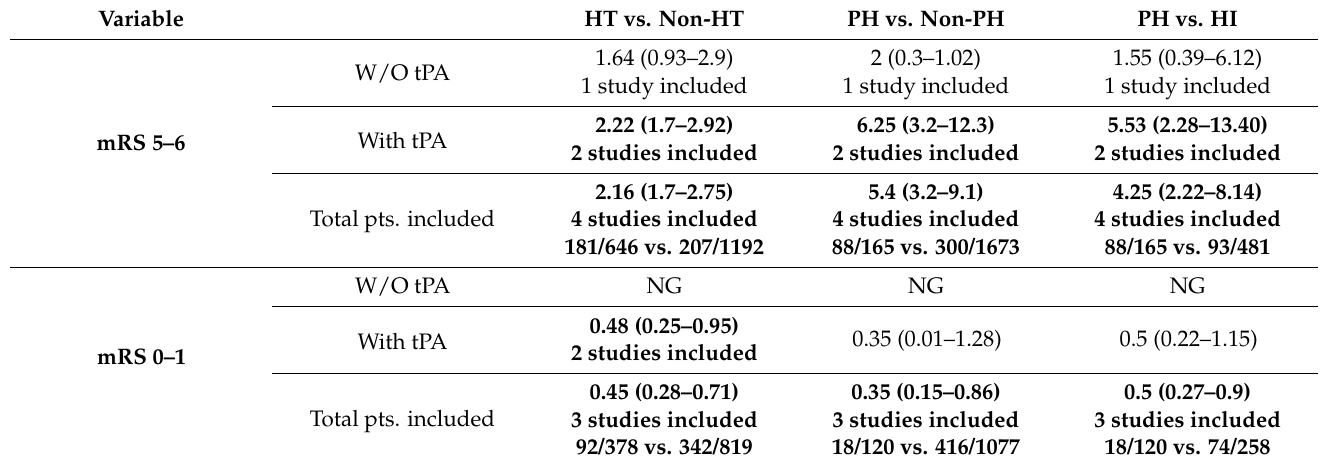
Table 4. Follow-up of patients with hemorrhagic